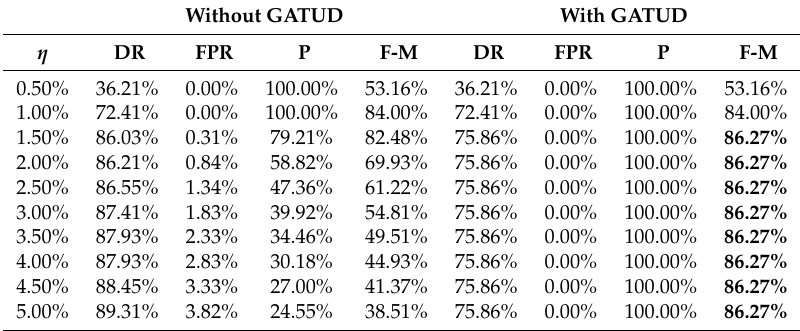
Table 7. The separation accuracy of abnormal observations with/without GATUD on MORD. Without GATUD With